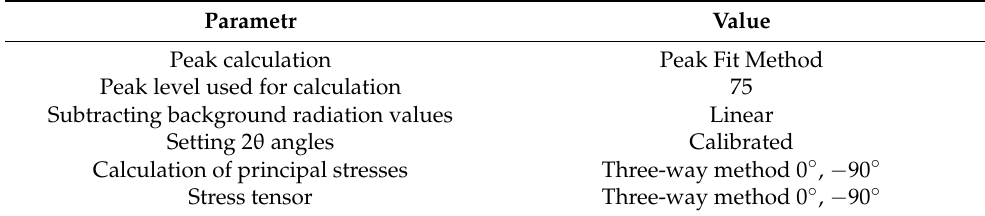
Table 5. Parameters of mathematical processing of OH measurement